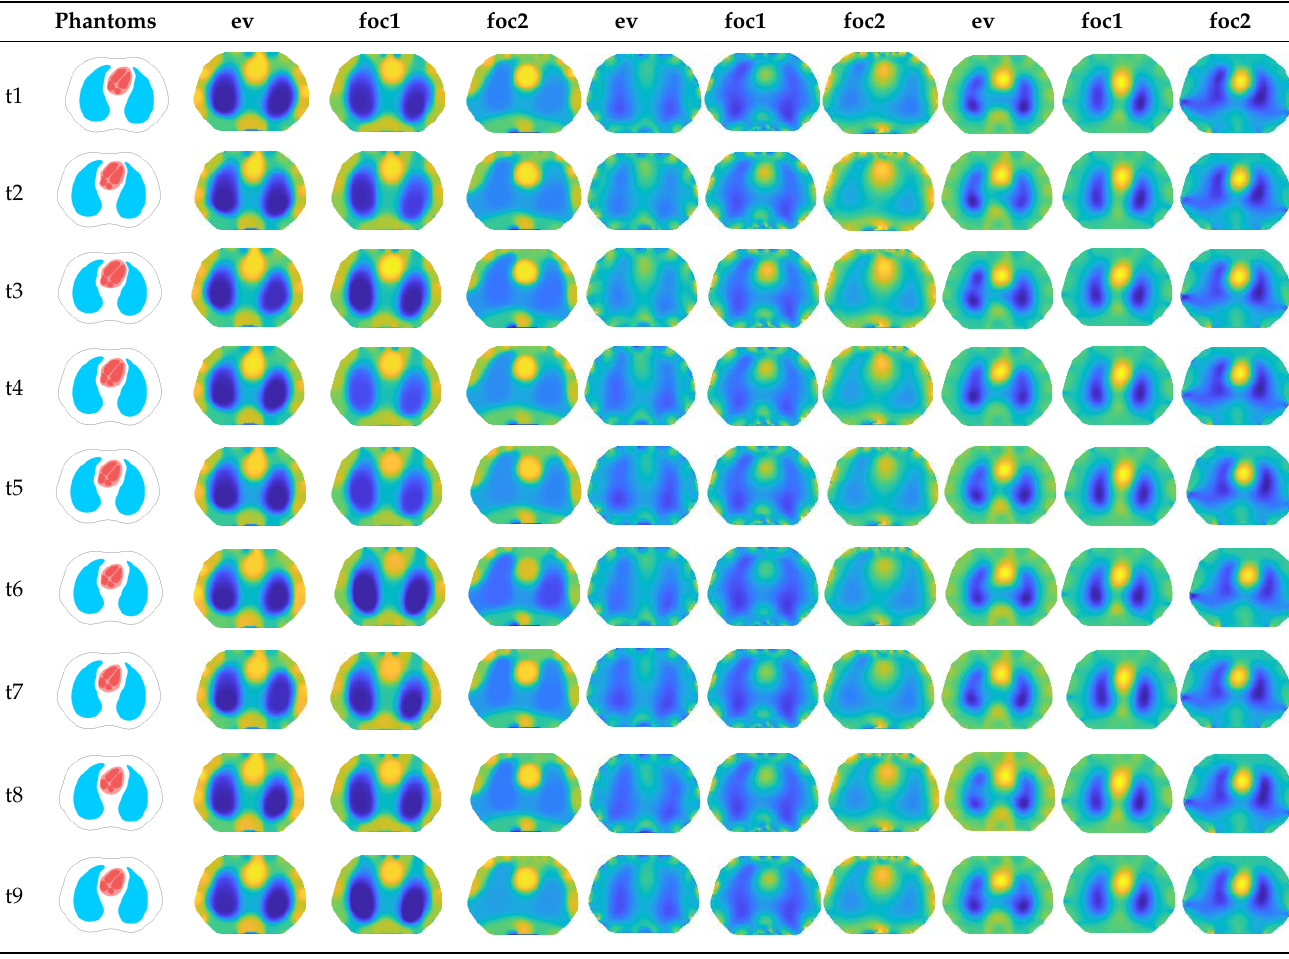
Table 2. Image reconstruction results from proposed optimized sensors and uniform sensors under different algorithms.